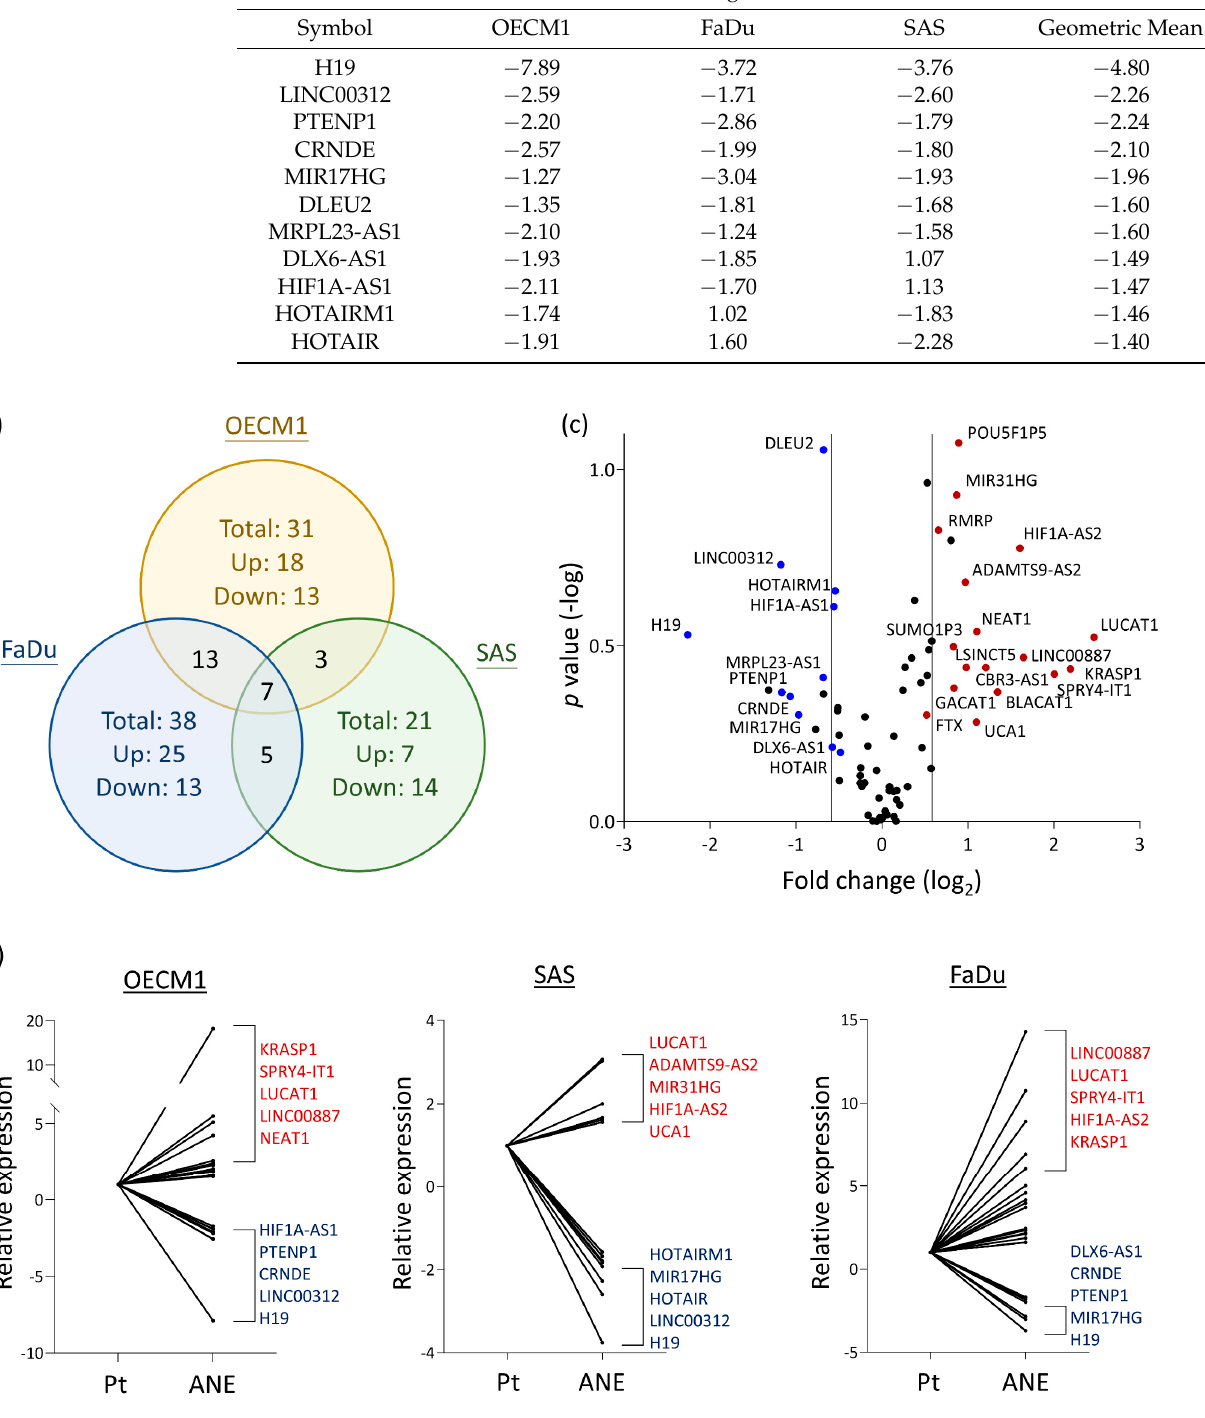
Figure 1. The dysregulated profile of 84 lncRNAs in response to areca nut treatment in three HNC cell lines (OECM1, SAS, and FaDu). ( a ) Summary of the dysregulated lncRNAs in each HNC cell line with chronic treatment by areca nut extract (ANE). ( b ) The most significant dysregulated lncRNAs induced by areca nut (ANE) compared to the parental cells (Pt) in each HNC cell line (OECM1, SAS, and FaDu). ( c ) The volcano plot shows the levels of dysregulated lncRNAs with the average |fold-change| ( X -axis) and the p -values ( Y -axis) among three HNC cell lines. The red dots represent upregulated lncRNAs (n = 17), and the blue dots represent downregulated ones (n = 11). Table 1. List of lncRNAs regulated by ANE .